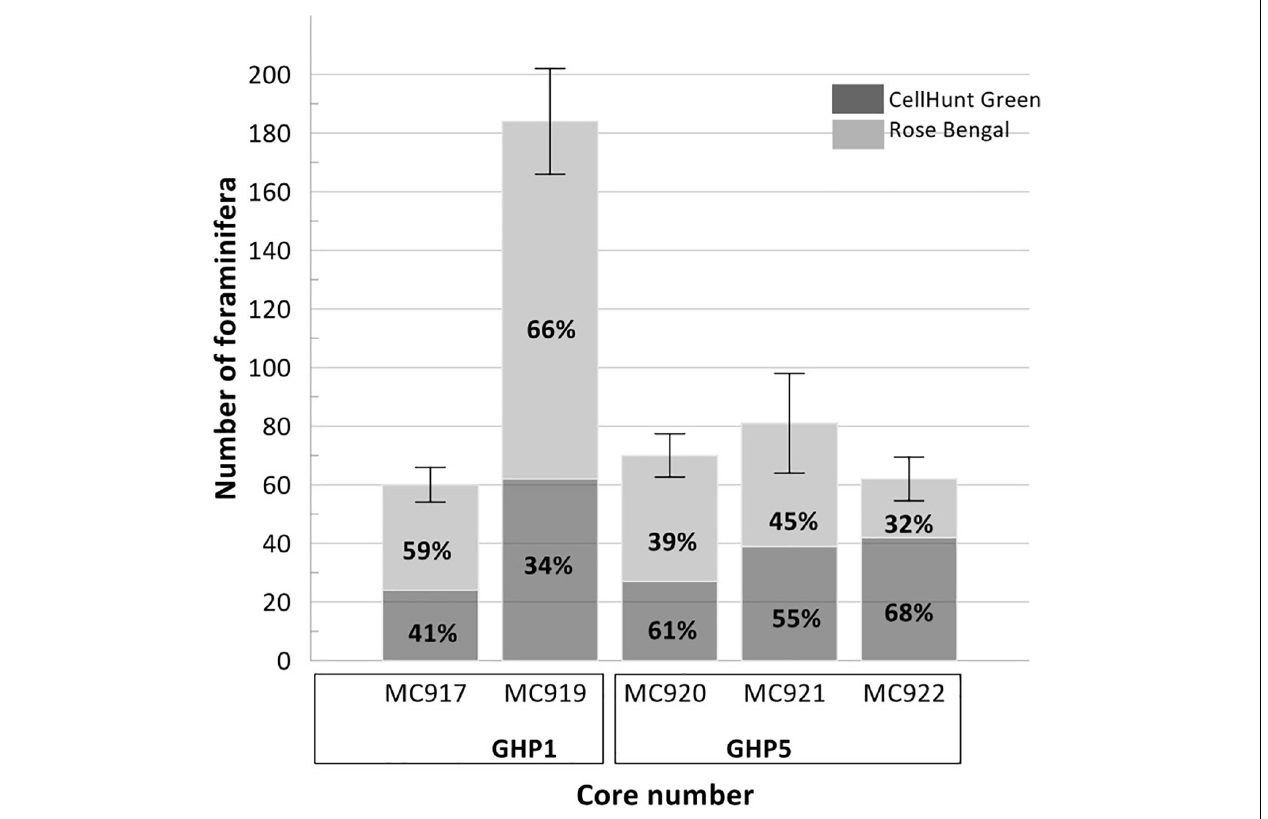
FIGURE 7 | Percentages of benthic foraminifera labeled with CellHunt Green (CHG) = live, and individuals subsequently stained with Rose Bengal (RB) = recently dead (direct count) from Storfjordrenna pingo. The number of foraminifera represents the sum of CHG (dark gray) and RB (light gray) individuals. Plot based on direct